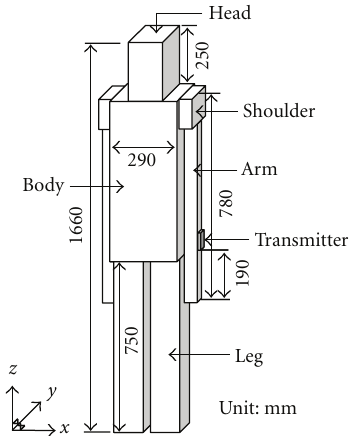
Figure 3: Simplified whole human body model [9].